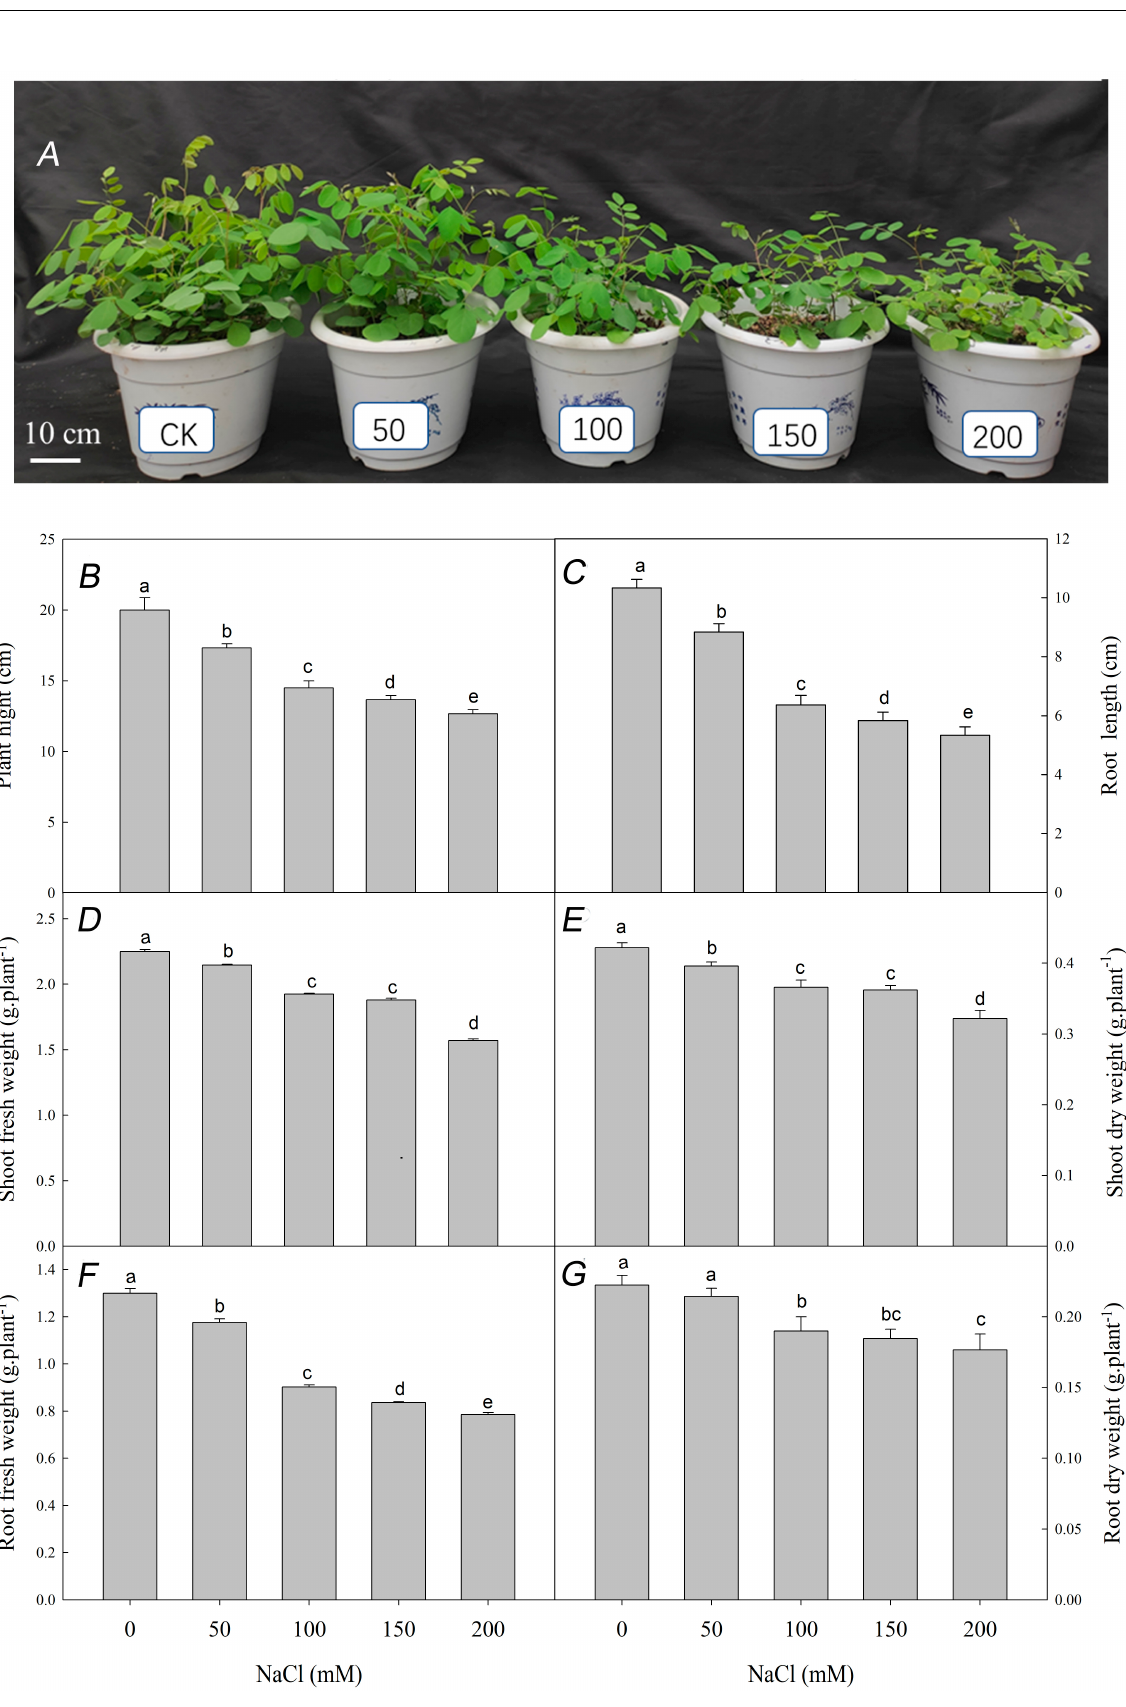
Figure 1. Effect of NaCl stress on the growth of R. pseudoacacia seedlings. ( A ) Seedlings under